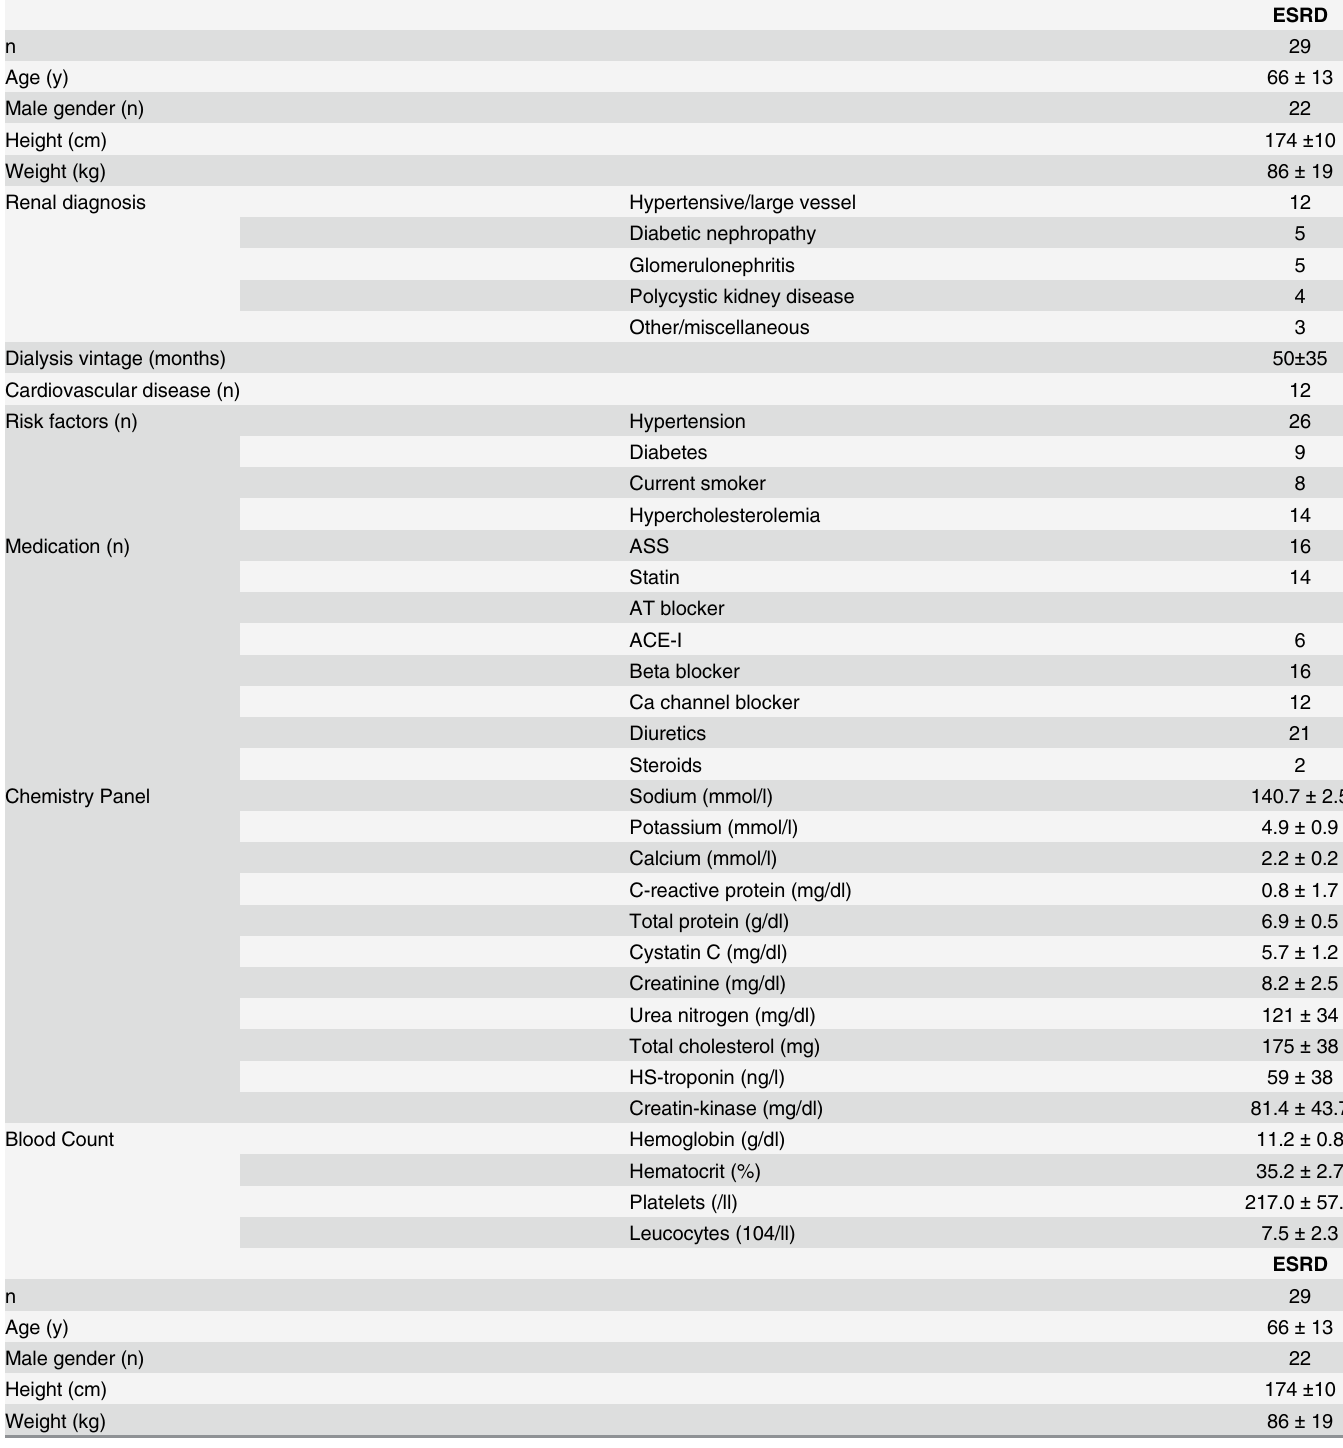
Table 1. Basic clinical and biochemical